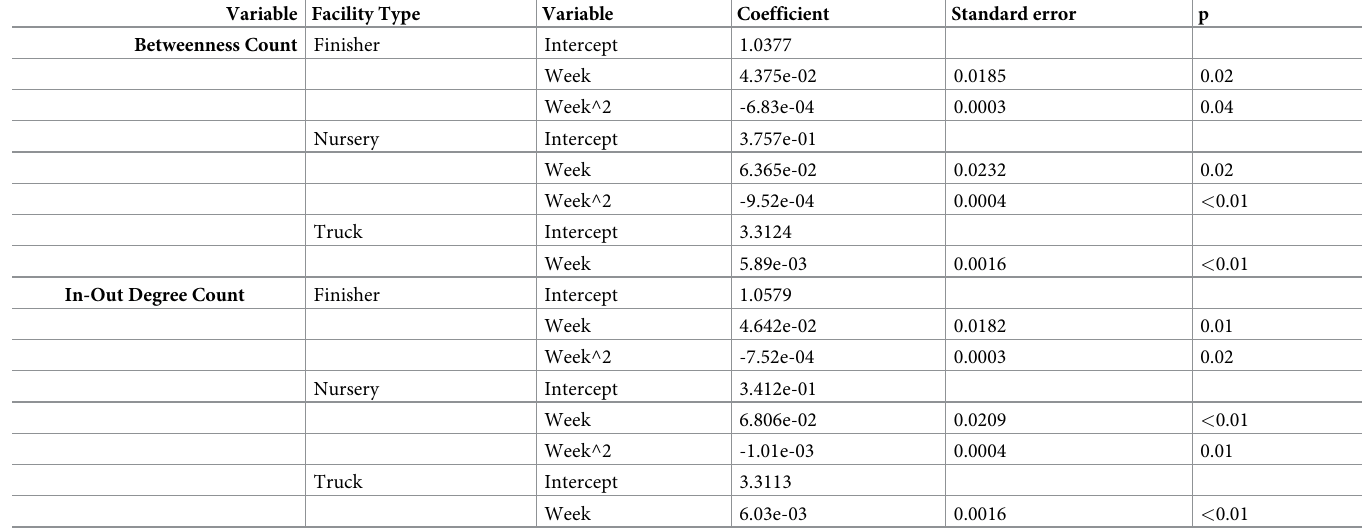
Table 4. Results of Poisson regression using the weekly count of three different types of facilities with betweenness or in/out degree exceeding 0 as an outcome, and different functional forms of time as explanatory variables.